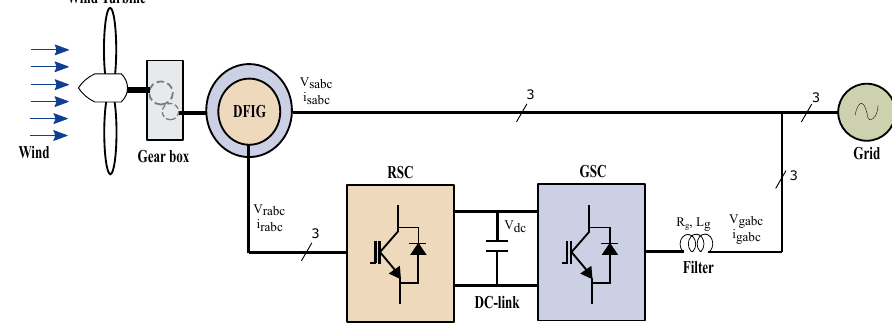
Figure 1. A simplified scheme of a DFIG-based wind energy conversion